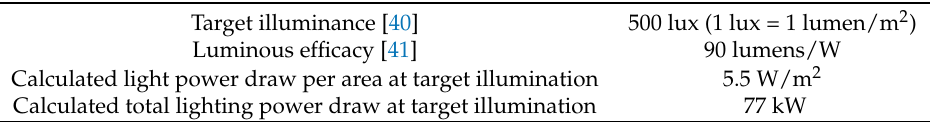
Table A6. Lighting